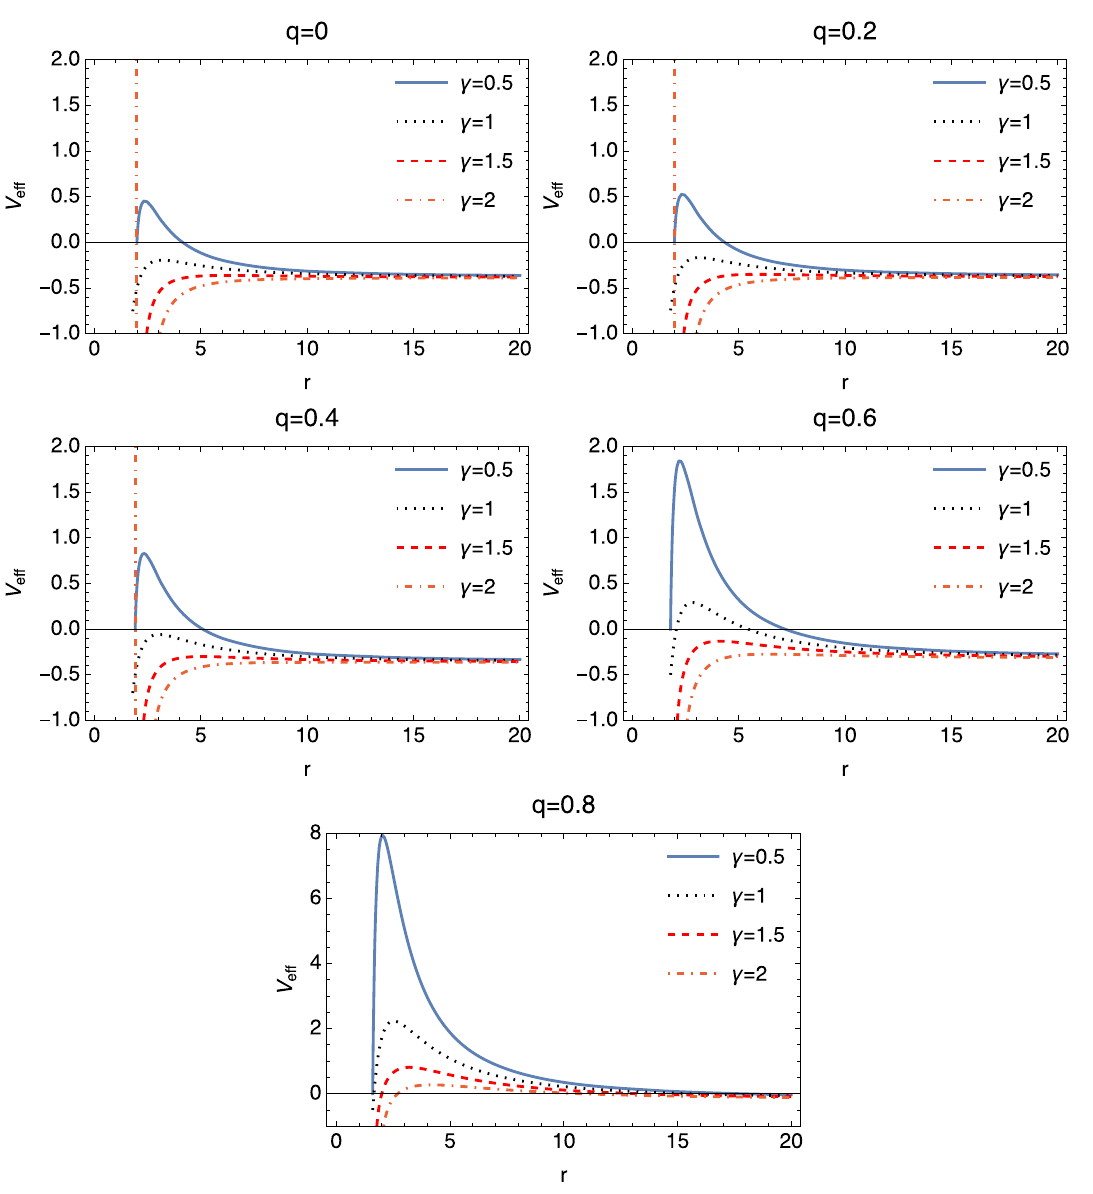
Fig. 2 Plot for the effective potential (59) for specific parameters m = 1, E = 1 and l = 15 . For comparison with the spherical case we added